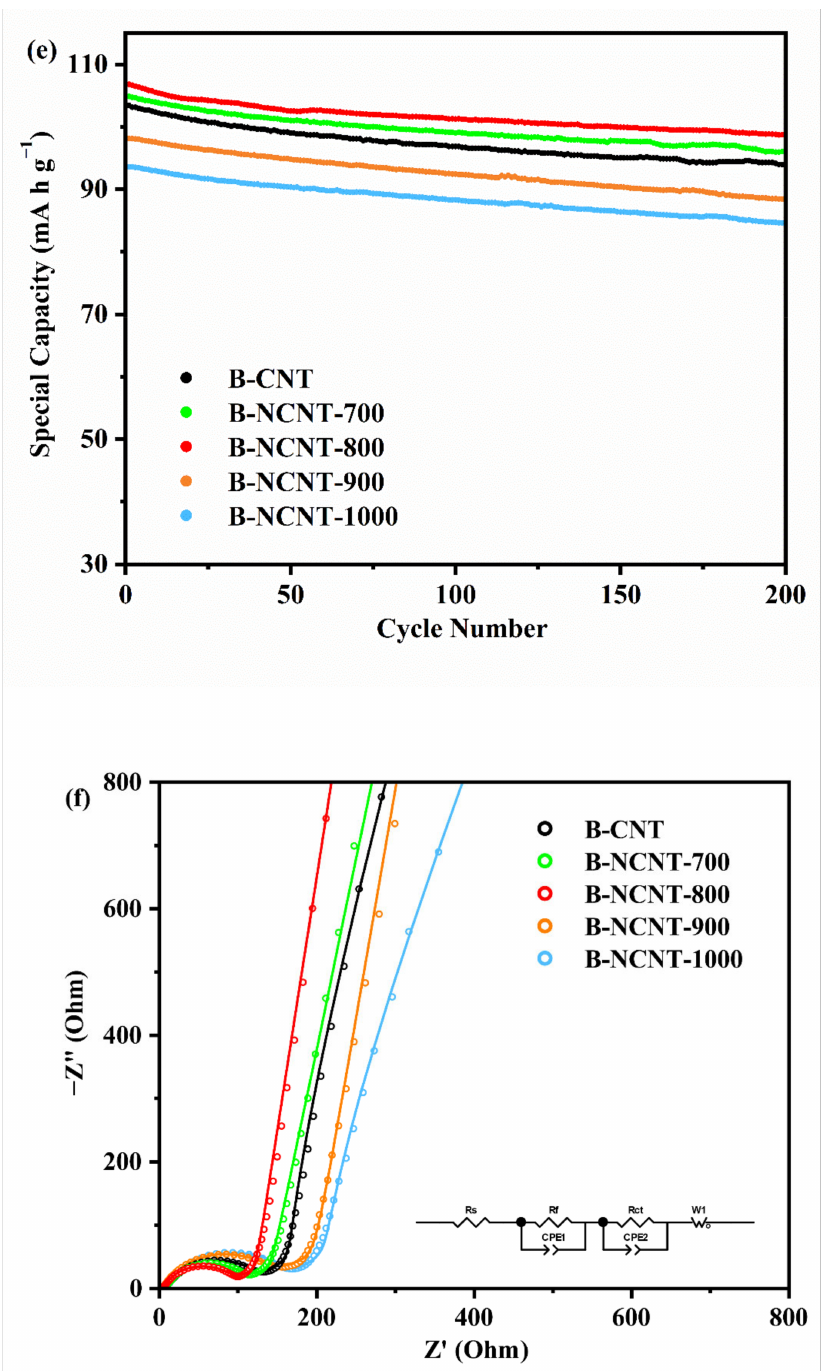
Figure 7. ( a – f ): Electrochemical performances of lithium-ion batteries. ( a ) Initial galvanostatic charge/discharge profiles at 0.1 C, ( b ) rate performance at 0.1–10 C, ( c ) cycling performance at 1 C, ( d ) cycling performance at 3 C, ( e ) cycling performance at 5 C, and ( f ) Nyquist plot and its fitted